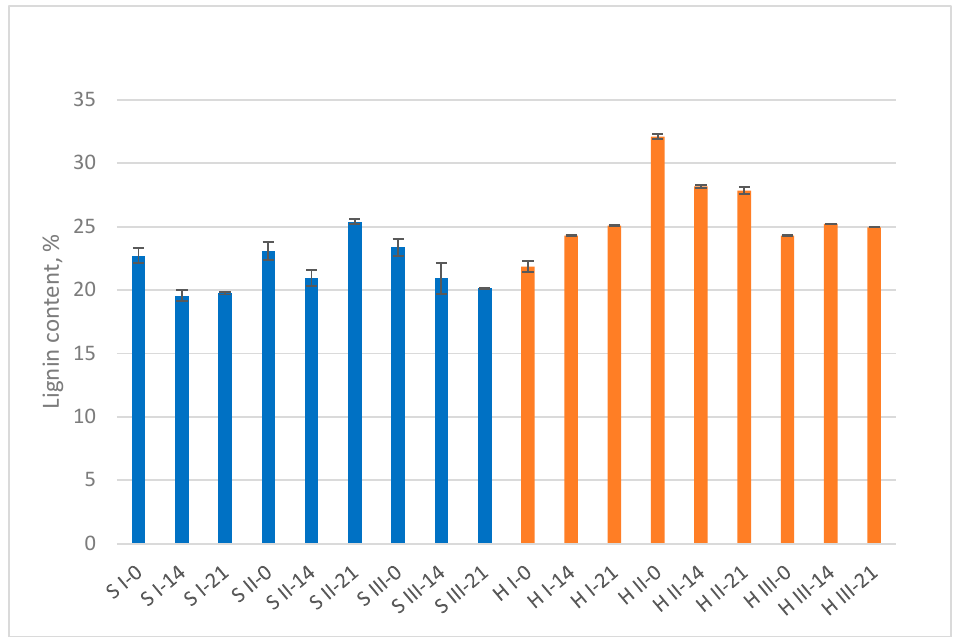
Figure 2. Lignin content at three mycelium biocomposites’ development stages: start point (0 days), 14 days, and 21 days (final sample). S = sawdust; H = hemp; I, II, III = variants.